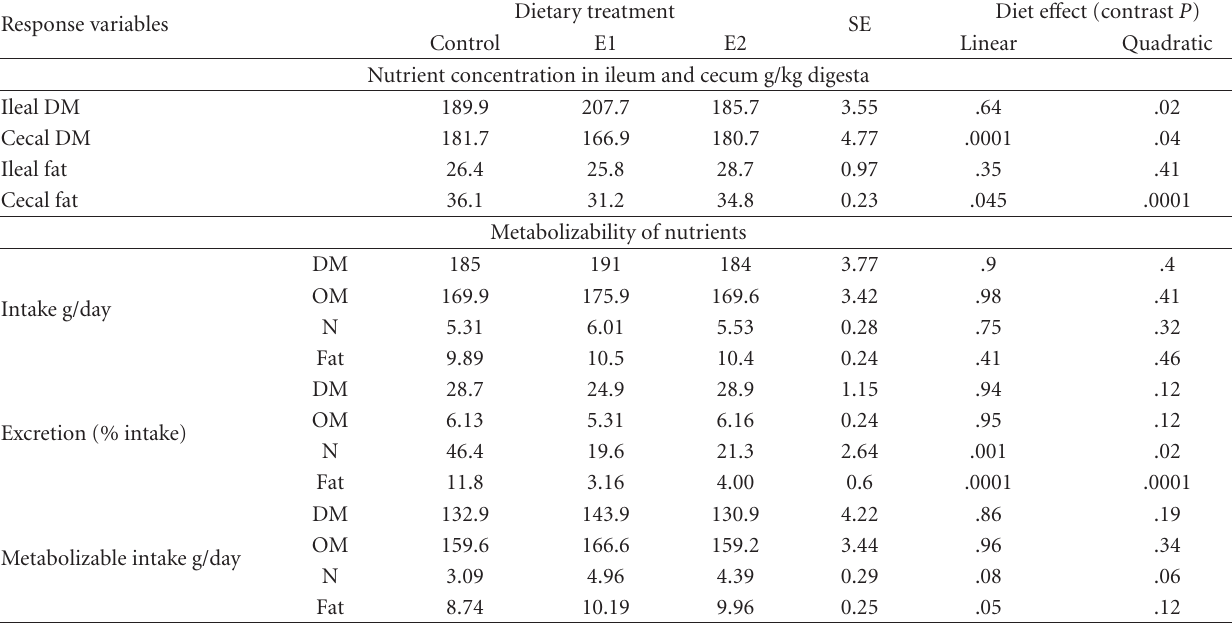
Table 5: Nutrient concentration in ileum and cecum and metabolizability of nutrients in broilers supplemented with graded levels of nutritional emulsifier a